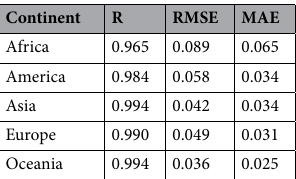
Table 9. The results of GEP estimating RWPC corresponding to the testing period in the world’s continents.